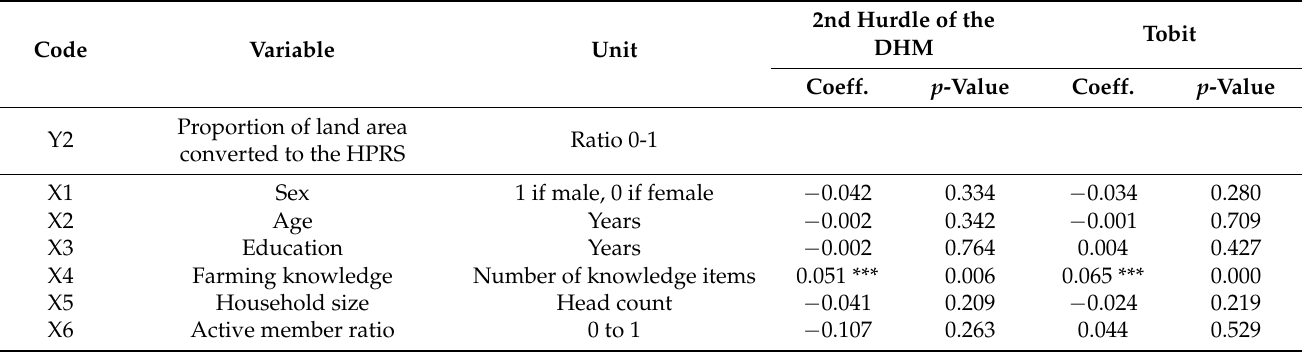
Table 8. The estimated determinants of the extent of farmland conversion to the HPRS: The second hurdle of the double-hurdle model (DHM) and the tobit